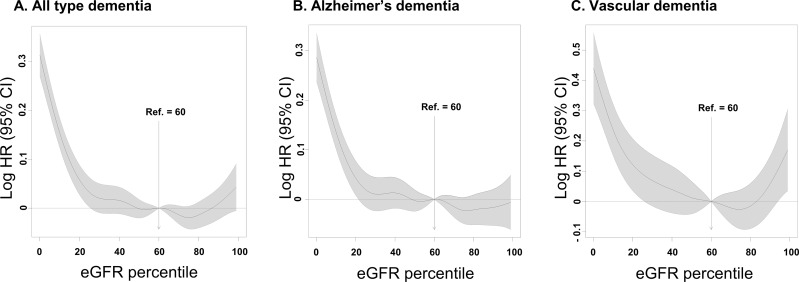
Spline curves for hazard ratios of all types of dementia (A), Alzheimer's (B) and vascular dementia (C) according to eGFR.